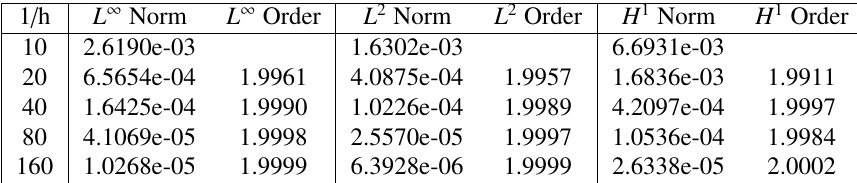
Table 5. Errors and Convergence Rate for Quadratic IFEM-CN Approximation for Example 1 1 /